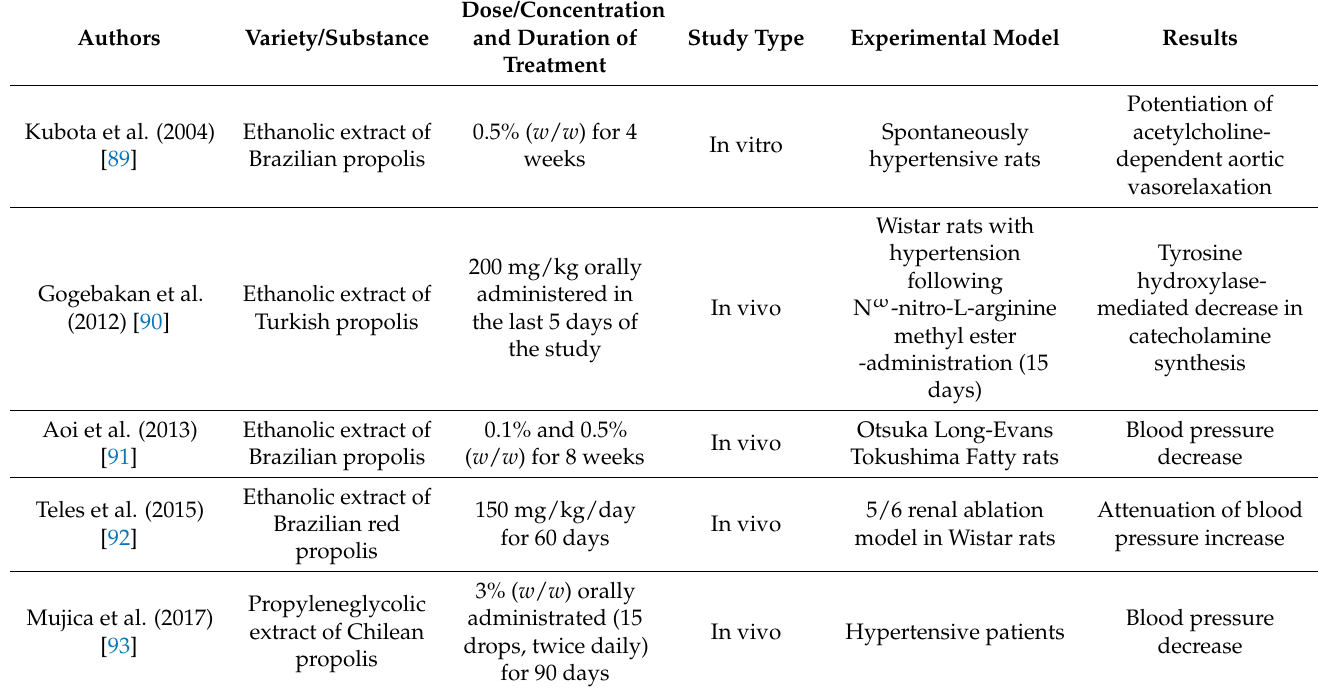
Table 4. Description and main results of the most relevant studies assessing the antihypertensive activity of